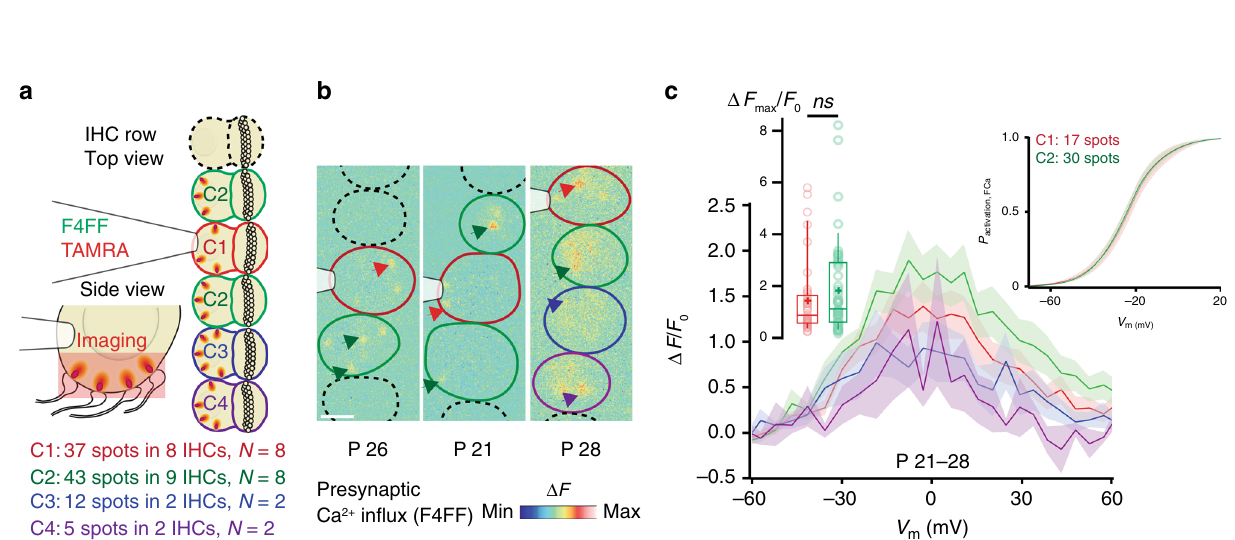
Summary of the total number of contacts, of fi lopodial contacts, fl at contacts, and putative fusion sites as well as of their average length in z-plane. Note, that we excluded one putative fusion site depicted in Fig. 5e, from the statistics of the P34 data as an outlier, as the z-measurements of 535nm clearly exceeds 1.5 times the interquartile range above the third quartile (75th percentile). Further, themaximumextentofthecytoplasmicbridgeofputativefusionsiteswasmeasuredinthexy-planeusing3dmod,asindicatedinSupplementaryTable1,andaveraged.Fortheage-groupofP15/16only1 examplefora fusion sitewas found andthe respecting values are listedin the Table. Data are presented asmean±S.E.M. P15/16: n = 3FIB-runs (2FIB-runs from P15, 1 FIB-runfrom P16) each with1 full IHC and the respective contactsto neighboringIHCs, N animals = 2. P34/37: n = 3 FIB-runs (2 FIB-runs from P34, 1 FIB-run from P37) each with 1 full IHC and the respective contacts to neighboringIHCs, N animals = 2. Per age group 2 independent embeddings were performed.